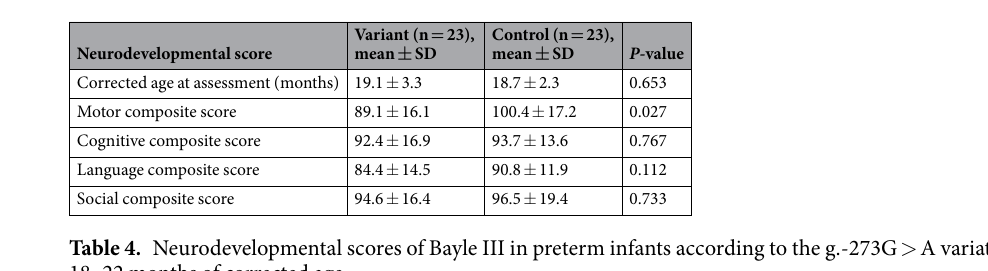
was obtained from Addgene (Addgene, Cambridge, MA, USA). The mutant vectors containing genetic variations in the promoter or coding regions were generated using QuikChange ® II Site-Directed Mutagenesis Kit (Agilent Technologies, Santa Clara, CA, USA) with primers shown in Supplementary Table S3. The sequences of all the constructs were confirmed by direct sequencing.